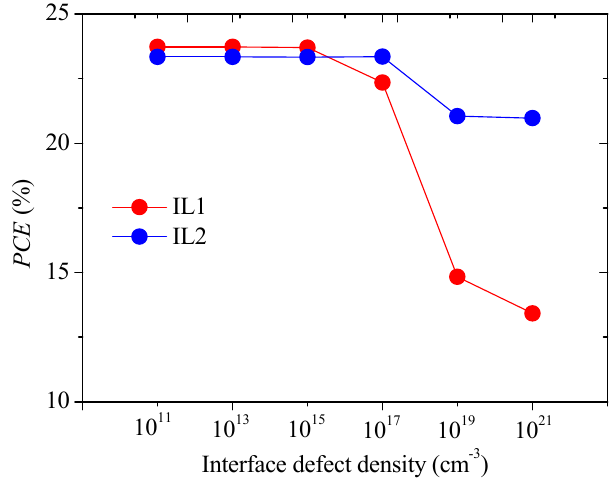
Figure 12. Effect of interface defect density on PCE.